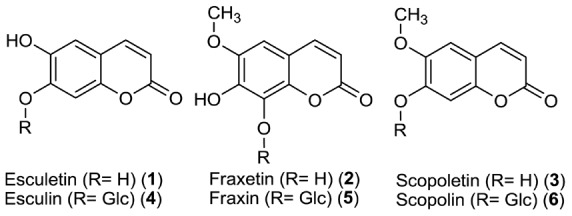
Structures of coumarins and their respective glycosides investigated in this study.